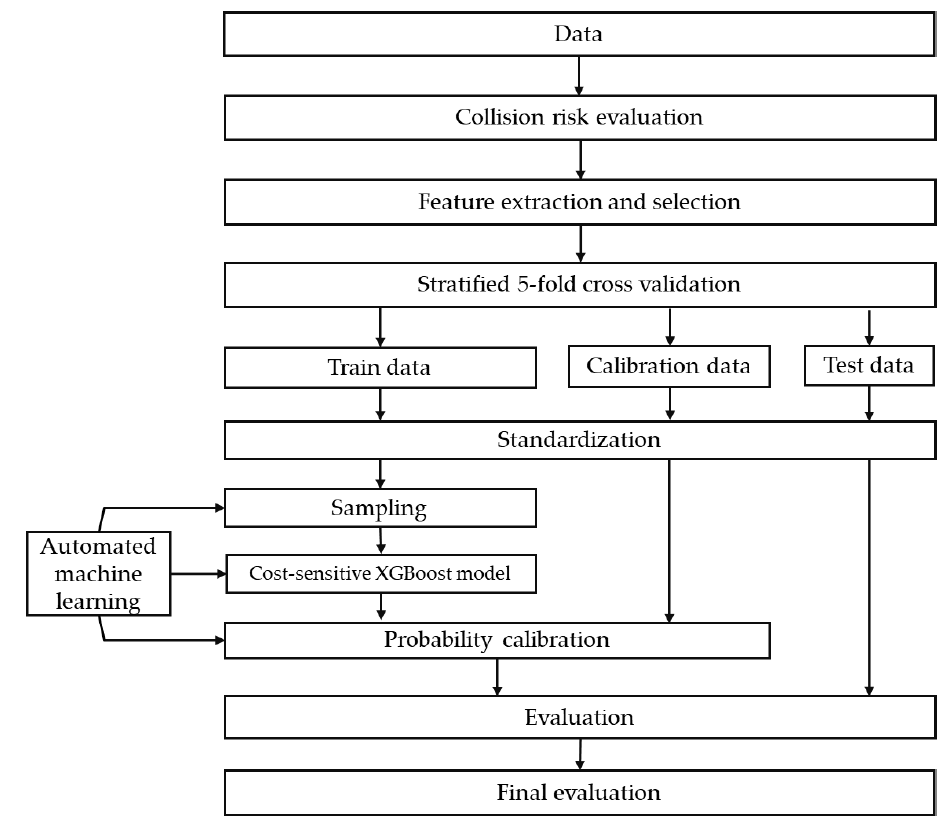
Figure 1. Methodology framework.